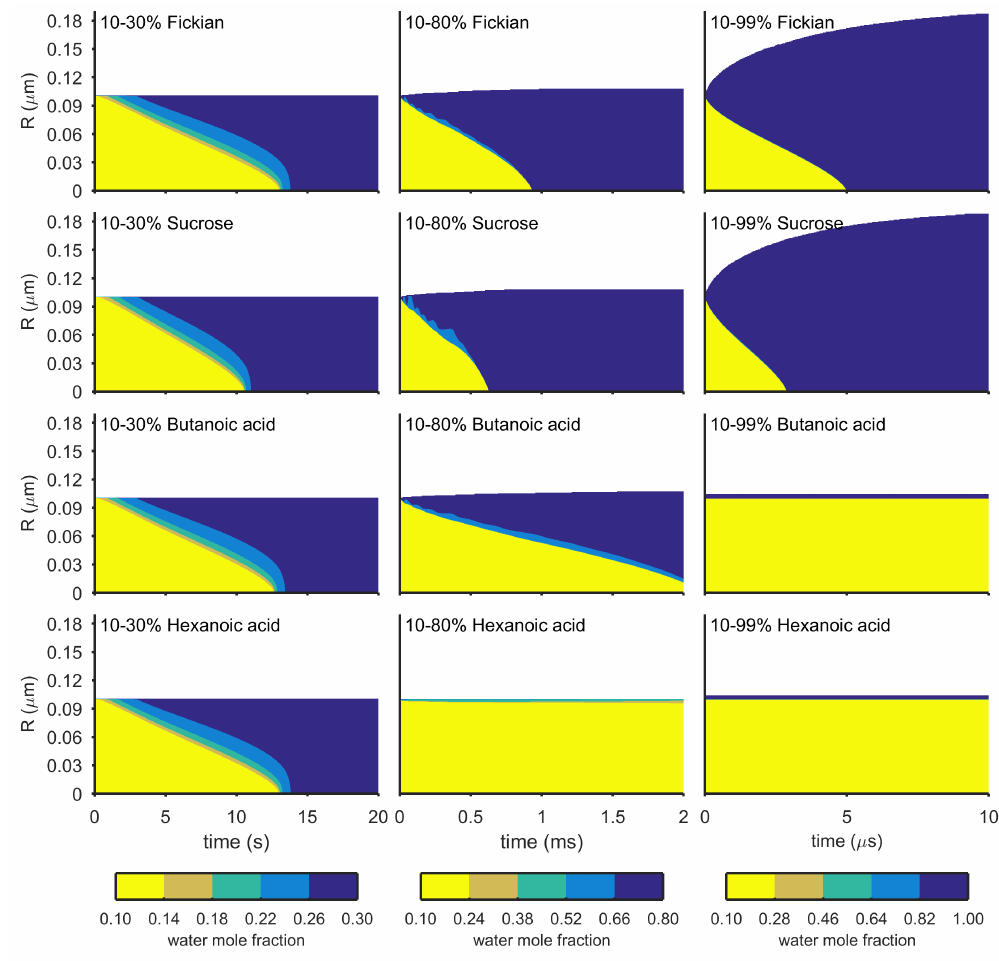
Figure 4. The change in water mole fraction as a function of radius through time after an initial increase in relative humidity from 10 to 30, 80 and 99%, at t = 0 in the left and right column respectively. Note that there is a different colour scale for each column to ensure clarity in the rate of mixing. The rows correspond to different non-volatile substances, with an arbitrary ideal species in the Fickian case, sucrose, butanoic acid and hexanoic acid from top to bottom. These simulations correspond to the Vignes diffusion coefficient and thermodynamic factors given in Fig. 2. The aerosol particles were initialized with a radius of 1 × 10 − 7 m and the self-diffusion coefficient of water